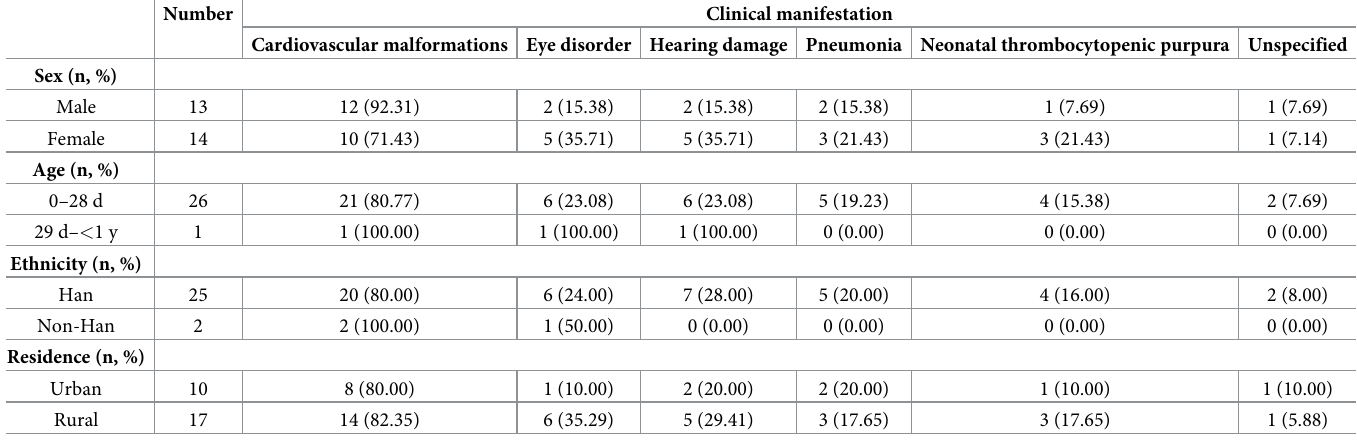
Table 3. The general sociodemographic characteristics of pediatric patients with CRS categorized by clinical manifestations during hospitalization from December 2015 to December 2020.